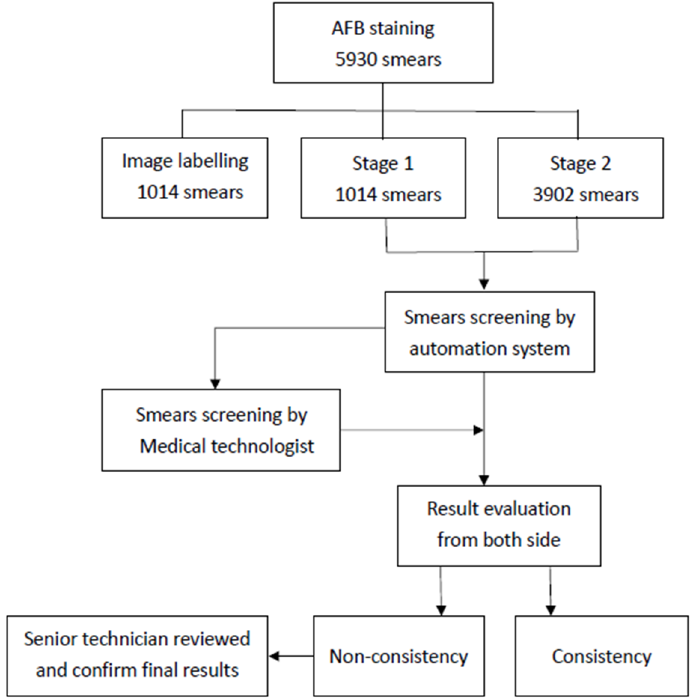
Figure 1. The general workflow of image processing and comparison of performance.